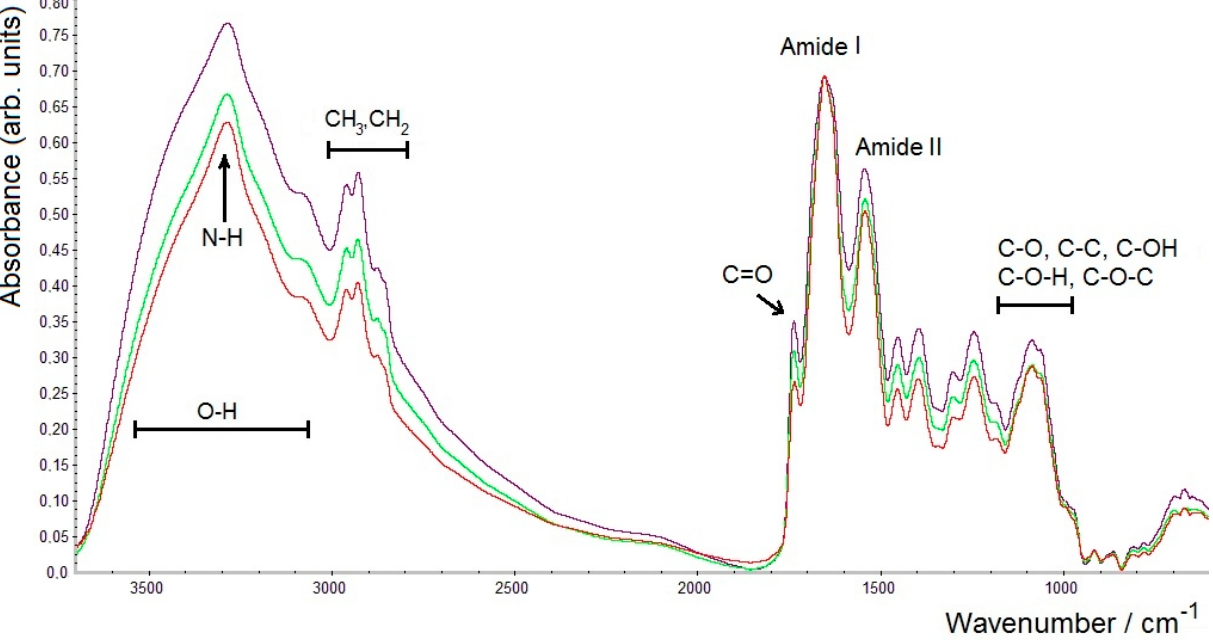
Figure 3. FTIR spectra of three samples of A. brasilense Sp7 biomass dried for 1.5 h (3 replicates) normalised by the amide I band.